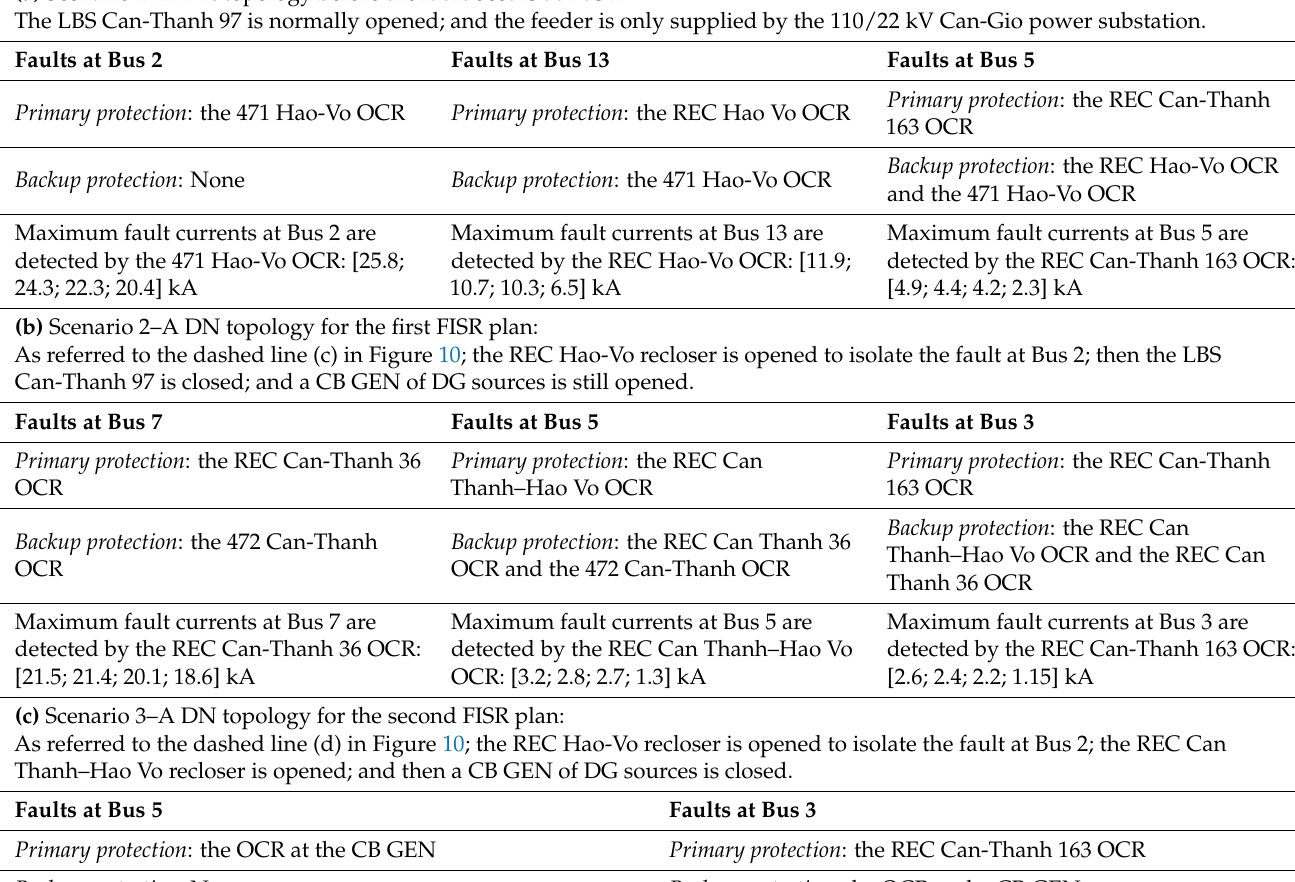
Table 3. Numerical fault-current calculation results are detected by the OCRs corresponding to four different operation scenarios of the real 22 kV distribution